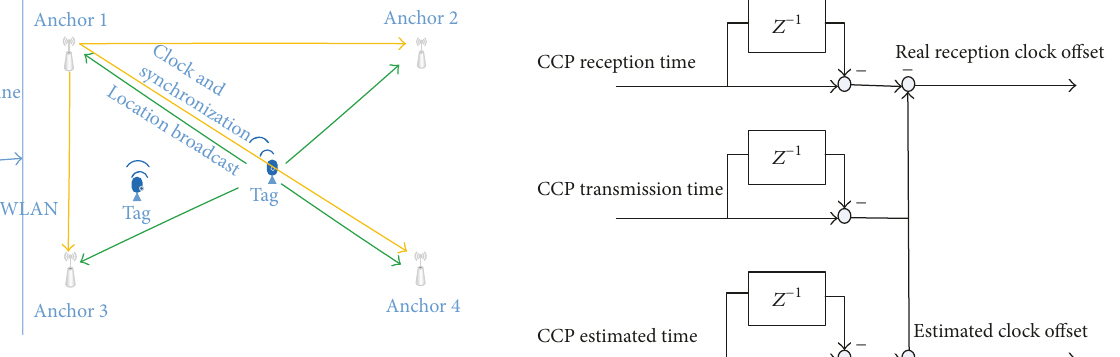
Figure 1: IR-UWB location system diagram.